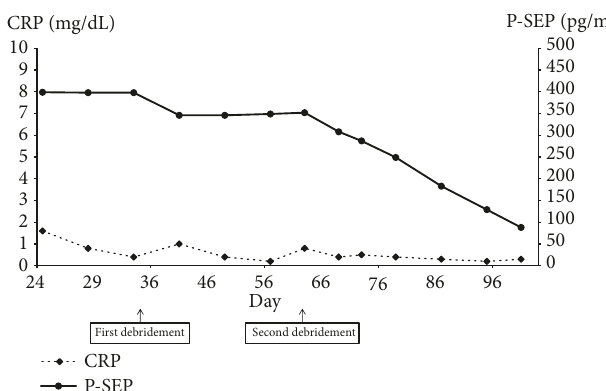
Figure 6: Time course of changes in P-SEP and CPR after the transfer to the general ward. Debridement was performed on day 34. Later, C-reactive protein (CRP) was 0.4–1.1 mg/dL, but P-SEP fluctuated between 350 and 380 pg/mL. On day 50, CT revealed a residual abscess. Therefore, we performed the second debridement on day 60. After that, P-SEP gradually